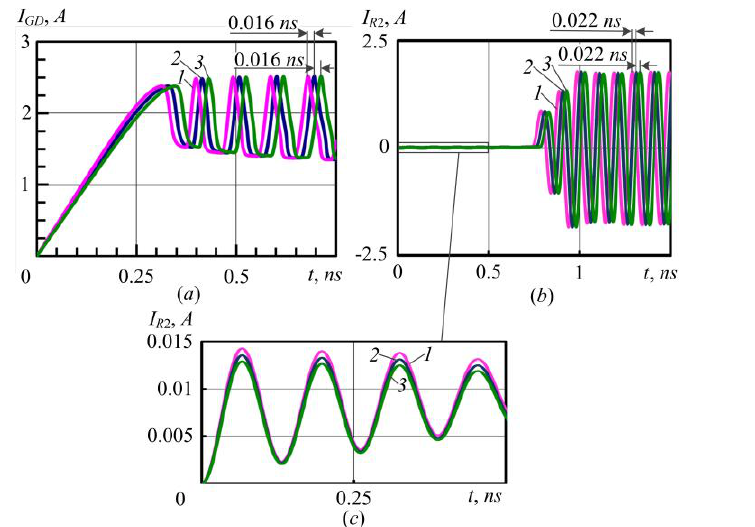
Figure 3 – Time dependences of the Gunn diode current at voltage pulse rise times t e of 0.95 (1), 1 (2), and 1.05 ns (3) for the single-layer structure (a) in the circuit with resistive load and (b) at the load R 2 in the equivalent circuit, U 0 = 20 V. Рисунок 3 – Профили тока диода Ганна в контуре с резистивной нагрузкой (a) и на нагрузке R 2 в эквивалентной схеме резонатора на рисунке 3 (b) : t e = 0.95 ( 1 ), 1 ( 2 ), and 1.05 ns ( 3 ); U 0 = 20 V. Слика 3 – Напонски профили Ганове диоде у колу резистивног оптерећења (а) и на оптерећењу R 2 у еквивалентном колу резонатора на слици 3 (б): t e = 0.95 ( 1 ), 1 ( 2 ), and 1.05 ns ( 3 ); U 0 = 20